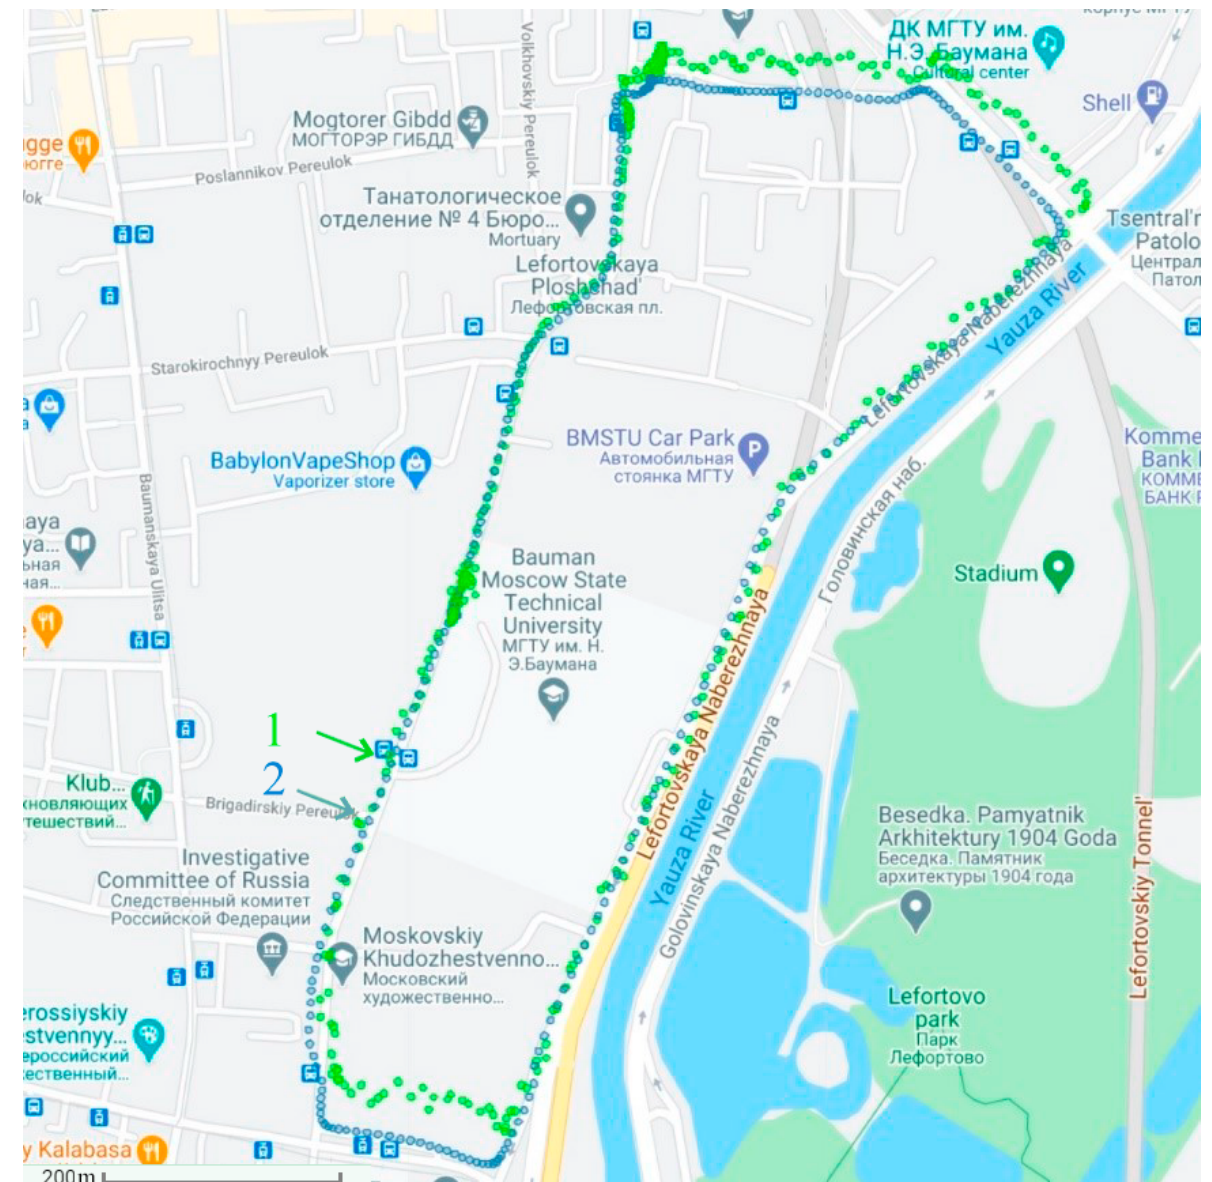
Figure 5. The positioning results of the SINS corrected by the GNSS (containing 15% abnormal measurements) using the KF: 1—positioning results; 2—actual